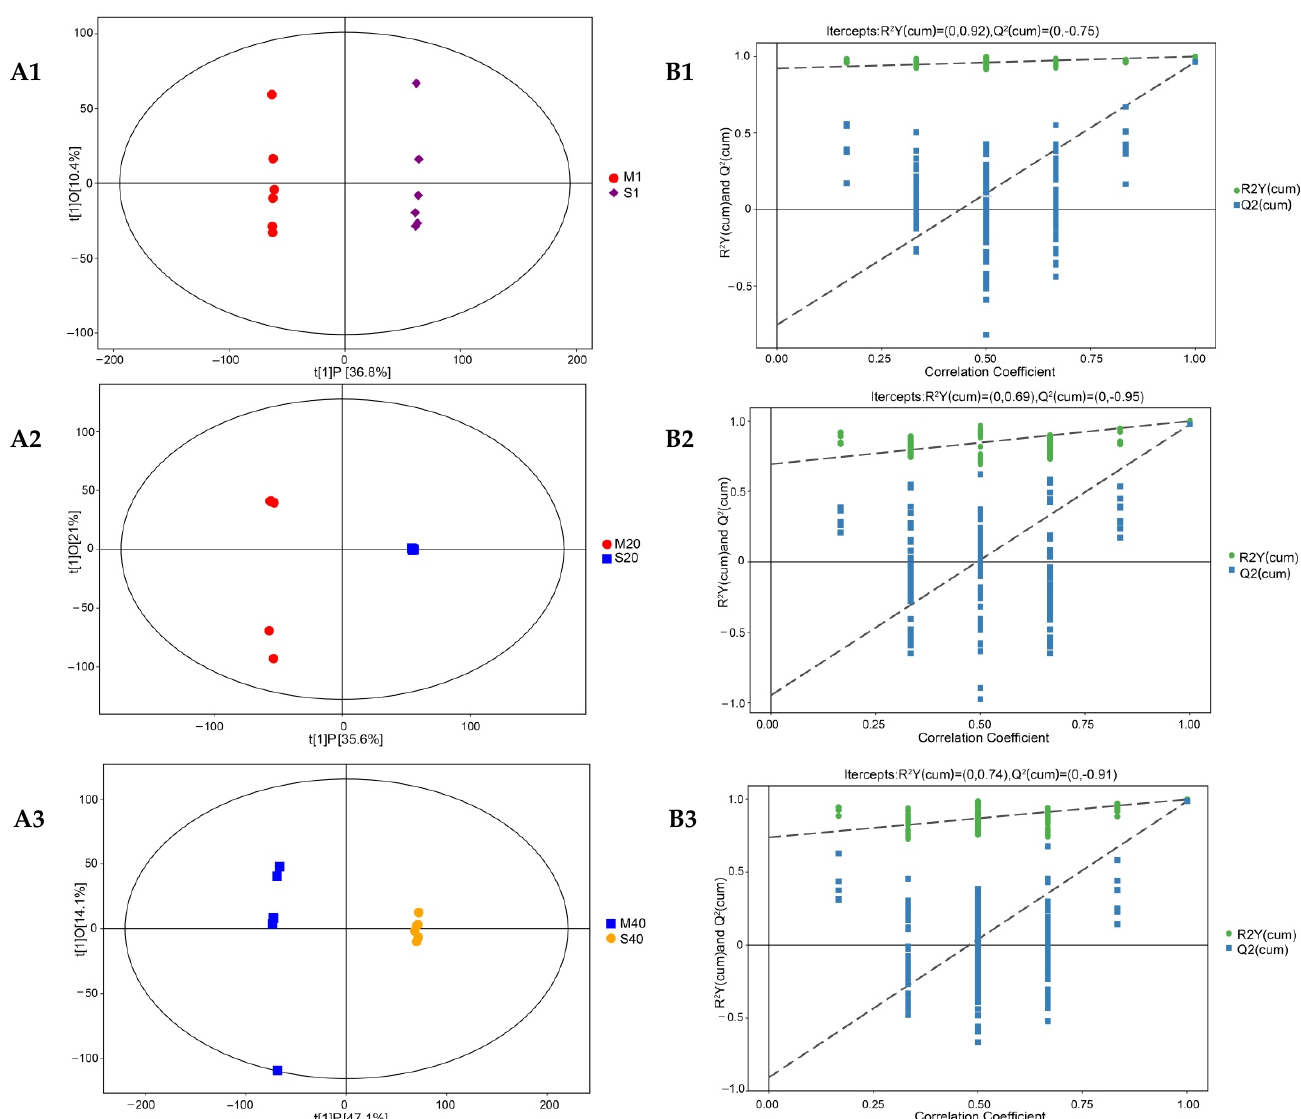
Figure 5. Score scatter plot and permutation test of OPLS-DA model for different groups. ( A1 – A3 ) represent score scatter plots of the OPLS-DA model of M1 vs. S1, M20 vs. S20, and M40 vs. S40. ( B1 – B3 ) represent permutation tests of the OPLS-DA model of M1 vs. S1, M20 vs. S20, and M40 vs. S40. The original model R 2 Y was very close to 1, indicating that the established model conformed to the real situation of the sample data. The original model, Q 2 , was very close to 1, indicating that if a new sample was added to the model, an approximate distribution would be obtained. Abbreviations: M, mixed-fermentation cheese; S, single-strain-fermentation cheese. Numbers 1–40 represent different ripening times (in days).